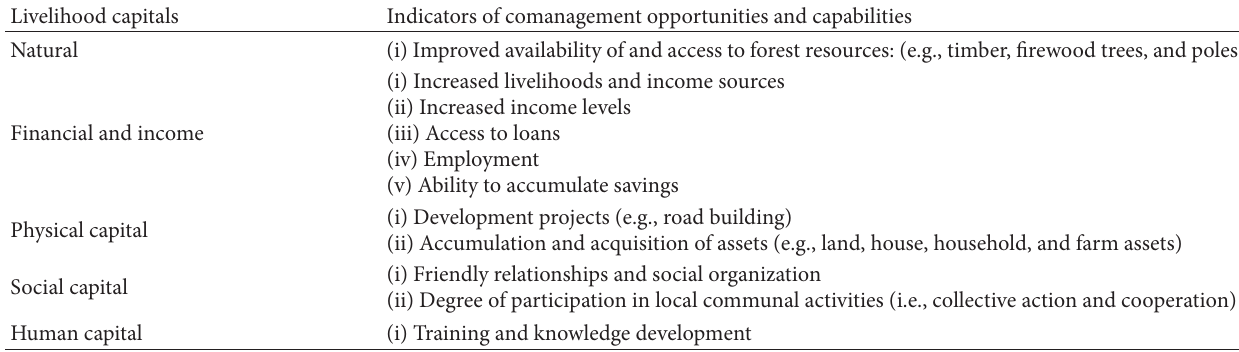
Table 2: Indicators of forest comanagement opportunities and capabilities for the different livelihood